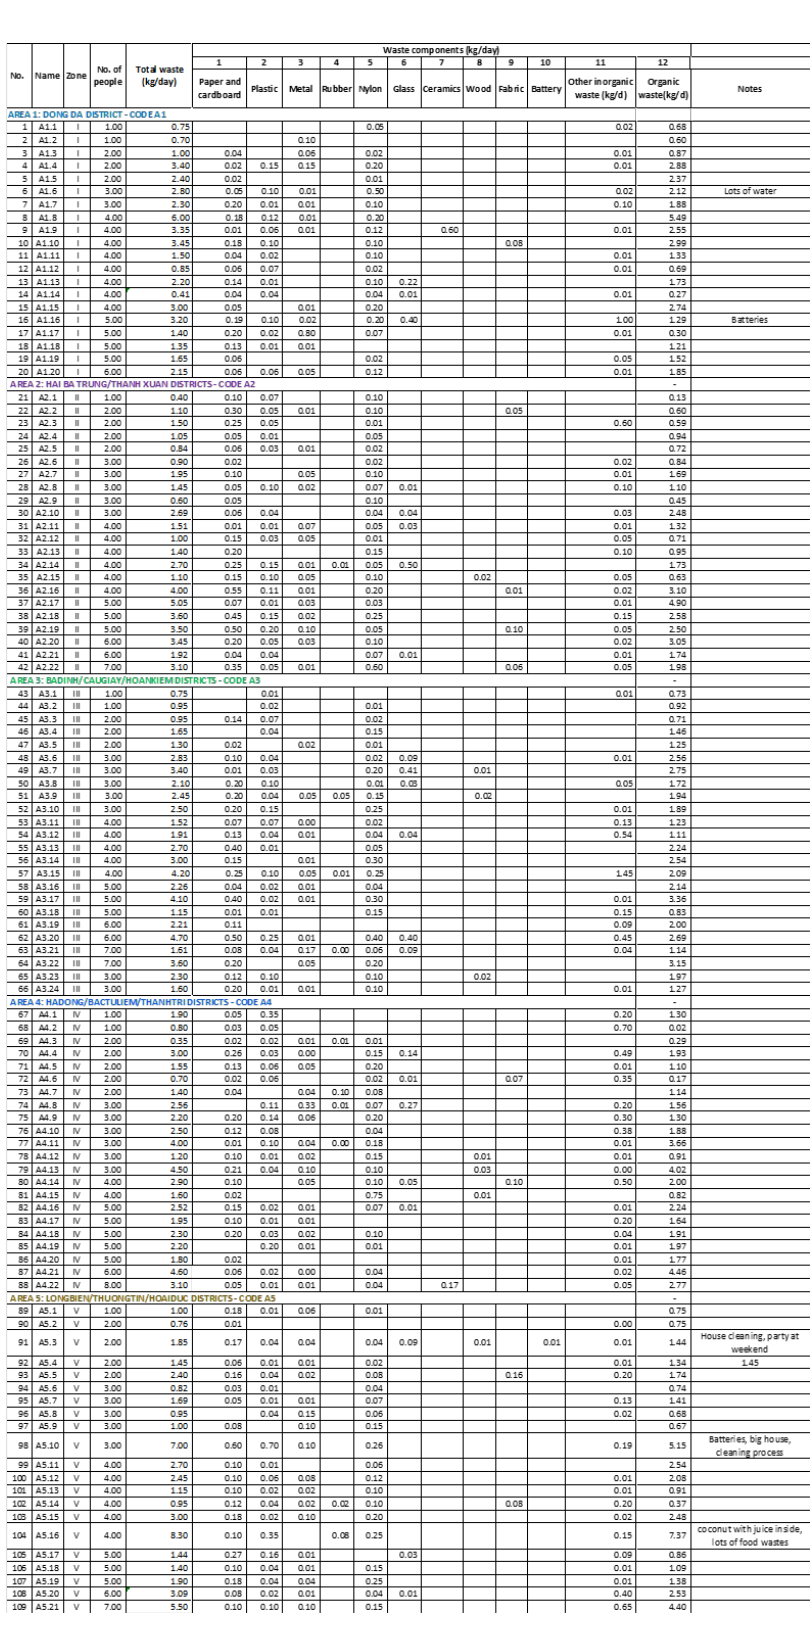
Figure A2. Detailed waste components for each sampling point.